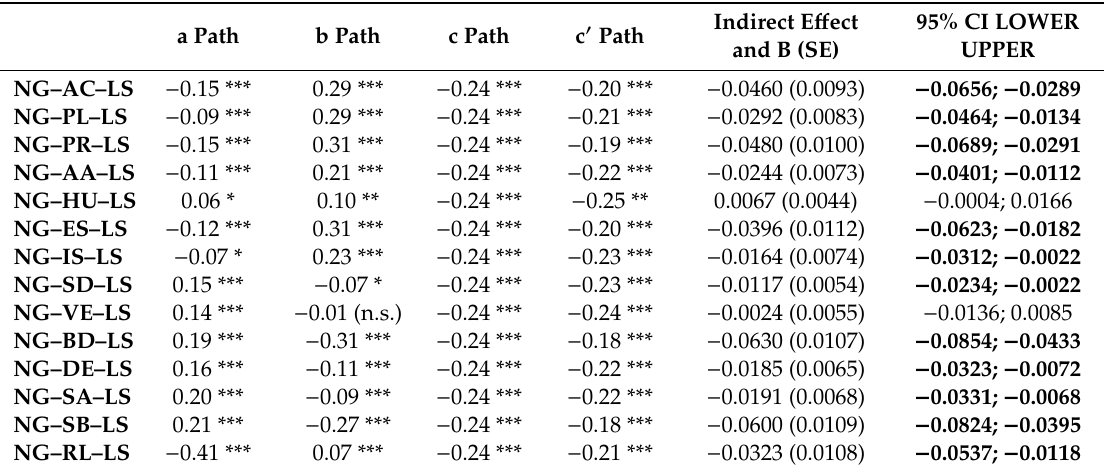
Table 5. The role of coping strategies on negative emotions toward God and life satisfaction (N = 744).